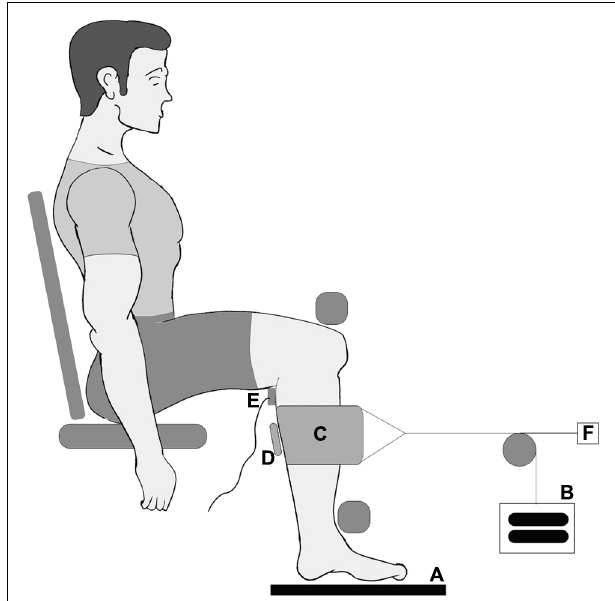
FIGURE 1 | Experimental design for the collection of force data and ultrasound data. Participants were seated in a custom designed chair with their right foot placed on a force plate (A) . Through the use of a pully system weights (B) loaded the sling (C) which was wrapped around the calf to apply transverse loads to the muscle. Ultrasound images (D) were taken of the medial gastrocnemius, and the muscle was stimulated using an electrode (E) on the tibialis posterior nerve. A draw wire sensor was used to measure to horizontal displacement of the sling (F)